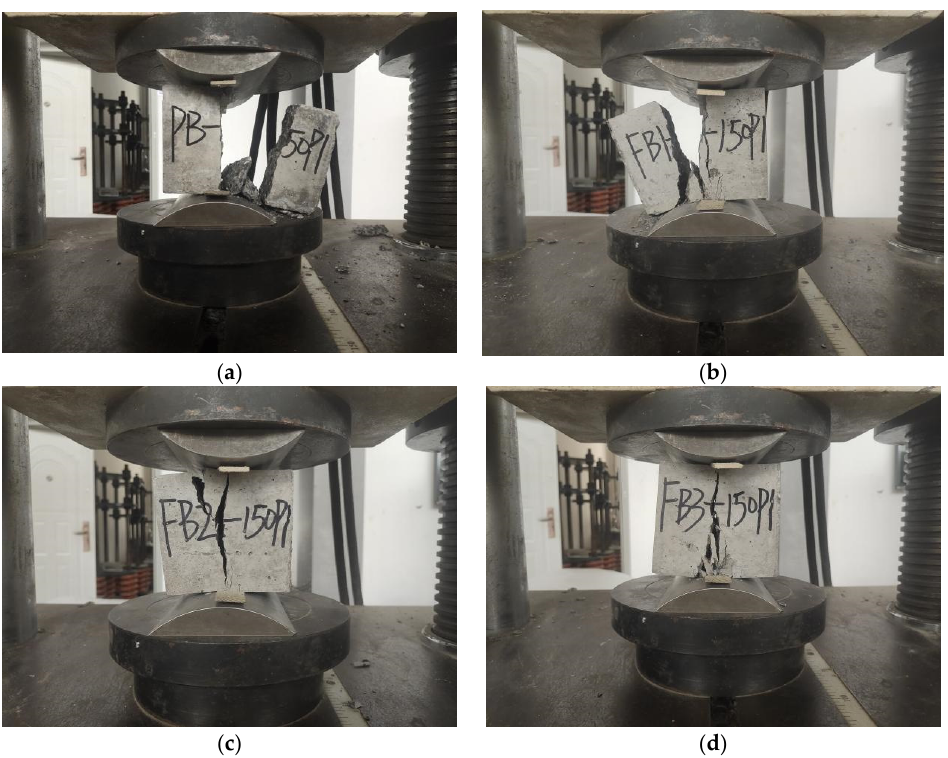
Figure 15. Splitting tensile damage characteristics of the specimen. ( a ) Volume fraction of 0%. ( b ) Volume fraction of 0.2%. ( c ) Volume fraction of 0.2%. ( d ) Volume fraction of 0.3%.